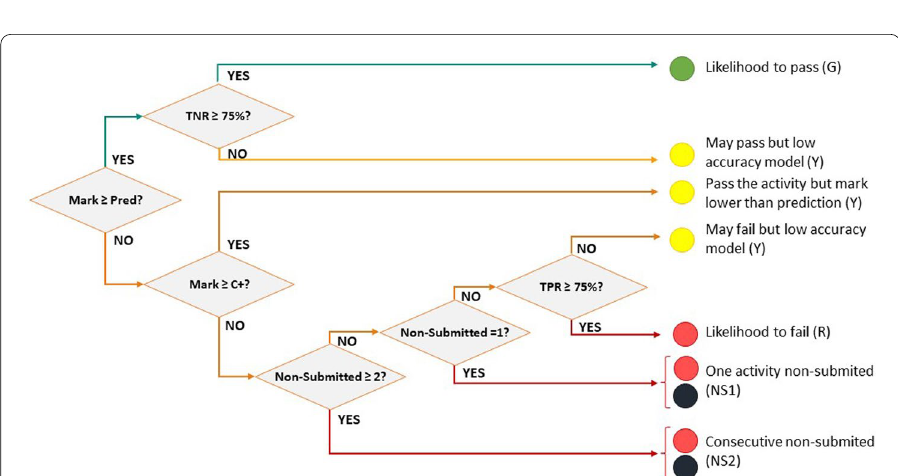
Fig. 2 Decision tree for risk level